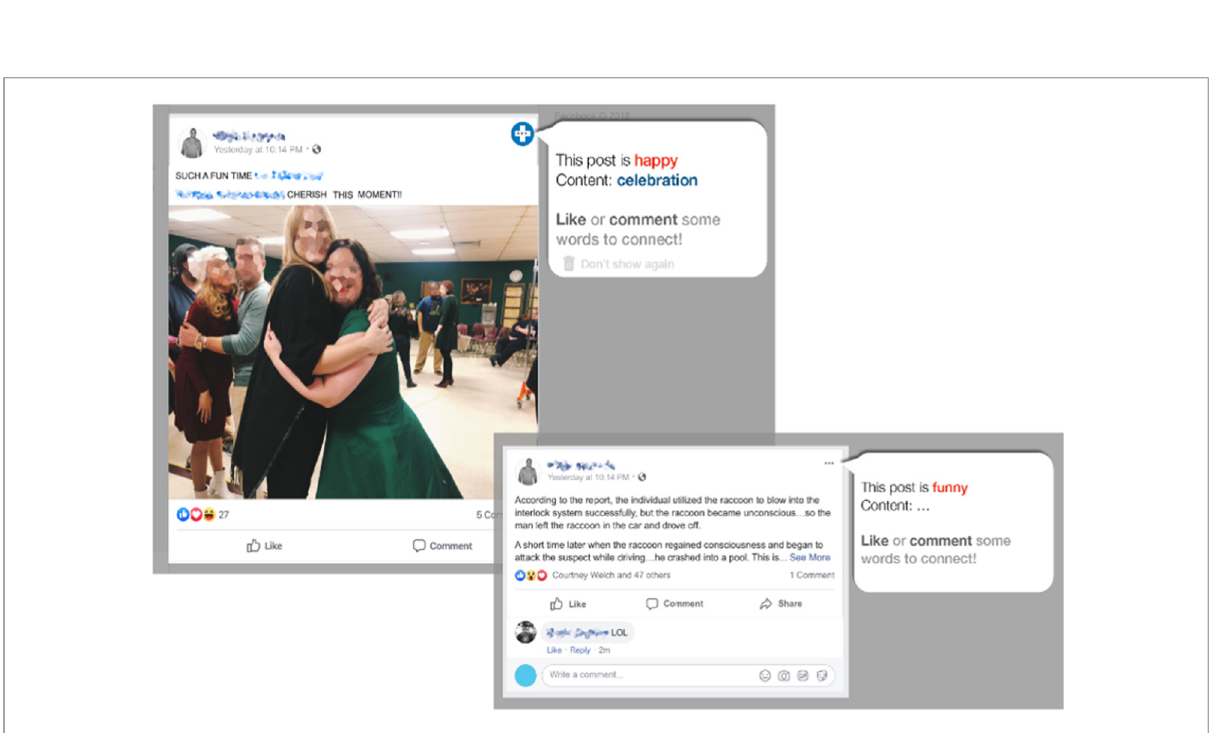
FIGURE 3 An example of the modi fi ed Facebook page using the social cue aid. Identifying information such as names and faces have been blurred to protect con fi